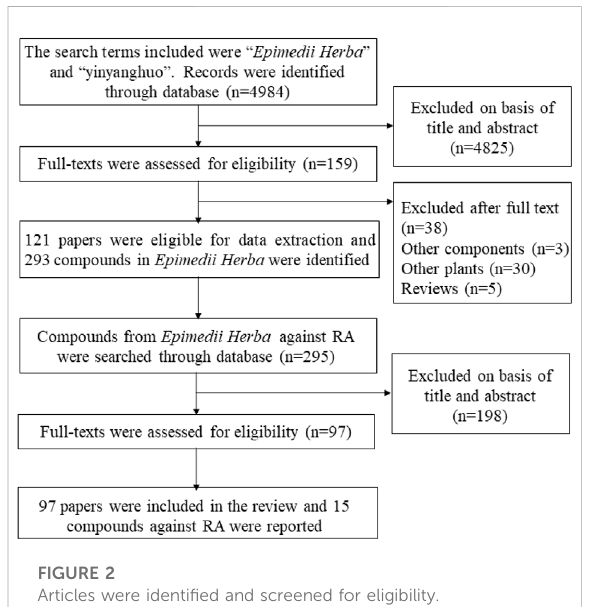
FIGURE 2 Articles were identi fi ed and screened for eligibility.